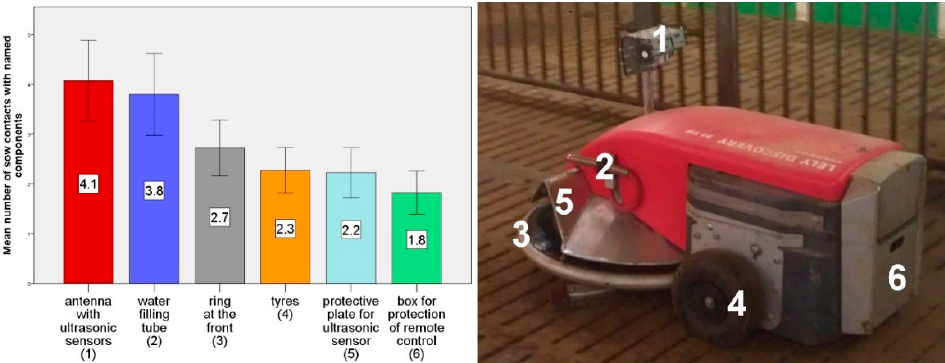
Figure 9. Left: Average number of sow contacts with individual components of the robot scraper in 30-minute observation period. Right: Components on the robot scraper.